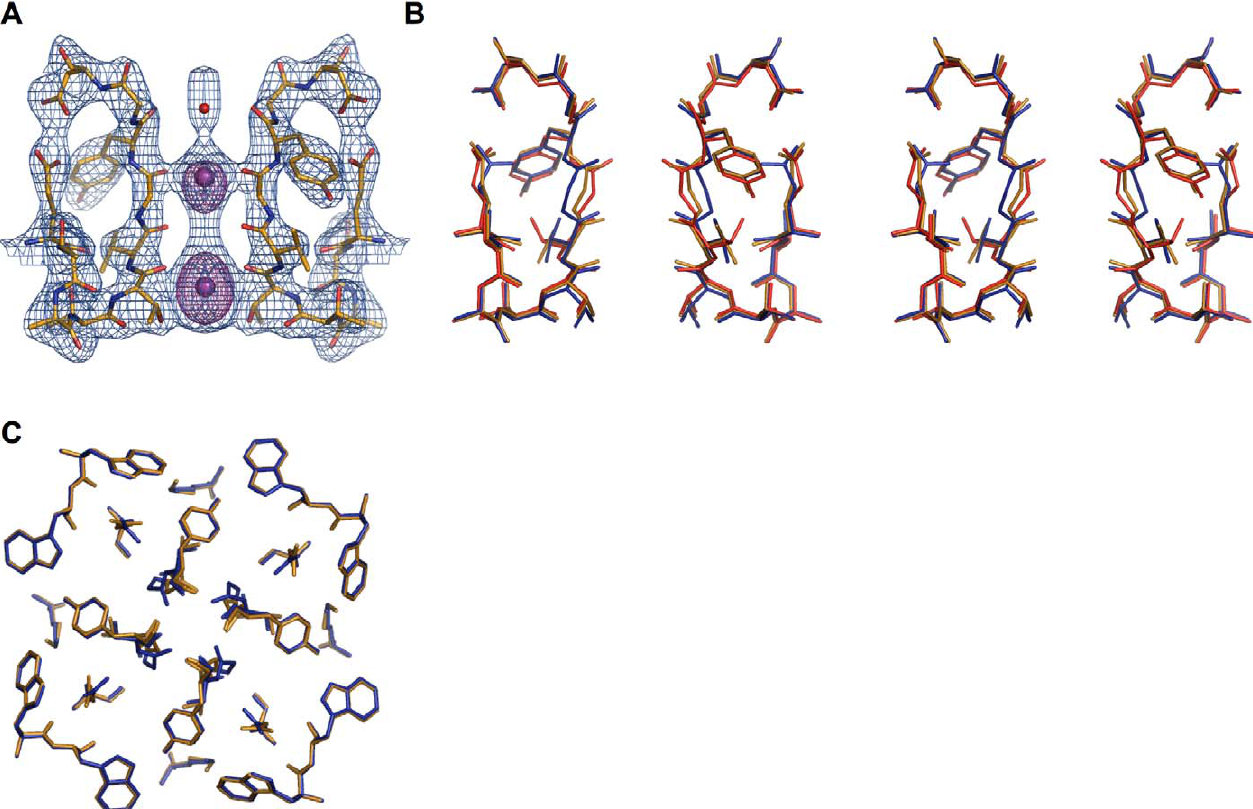
Figure 6. Structure of the Selectivity Filter with Ba 2 þ Bound Inside (A) A 2Fo-Fc electron density map (colored in blue and contoured at 2 sigma) of the selectivity filter region show two diagonally opposing subunits. Ba 2 þ ions (in magenta) and H 2 O (in red) are shown as spheres within the filter. The anomalous difference density map is shown in magenta as a fine mesh (contoured at 10 sigma) and was used to identify the Ba 2 þ ions. (B) A stick representation shows a comparison between the selectivity filter of the Ba 2 þ bound structure (yellow) with the collapsed (red) and conductive (blue) K þ bound structures. (C) Comparing the Ba 2 þ - bound (yellow) and conductive conformation (blue) structures shows that the Ba 2 þ - bound structure adopts the conductive conformation at distant sites along the plane of aromatic amino acids surrounding the selectivity filter.